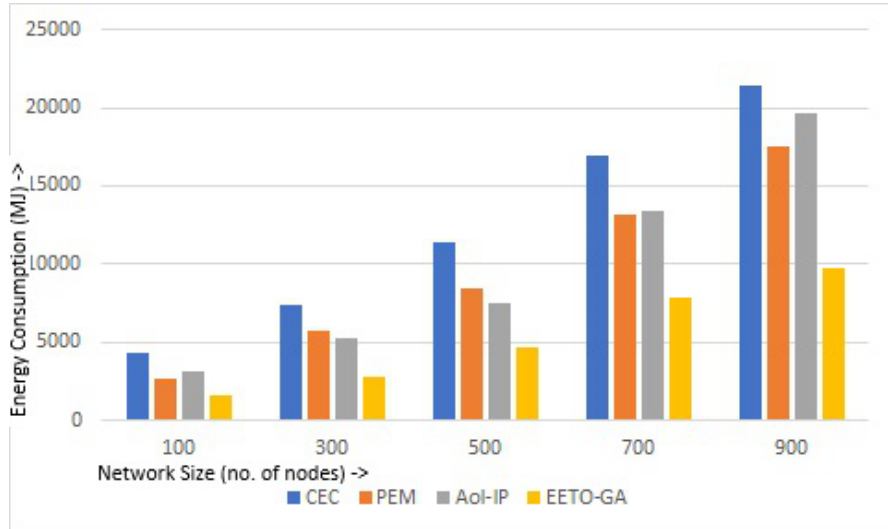
Figure 3. UAV -Energy-Consumed (UAV-E) in Proposed EETO-GA and Other State-of-the-art.